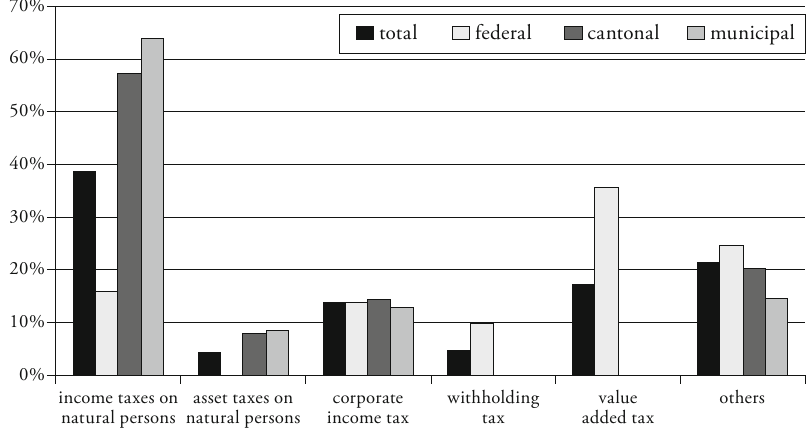
Figure 5: Swiss Tax Revenue Breakdown in 2011 by Tax Type and State